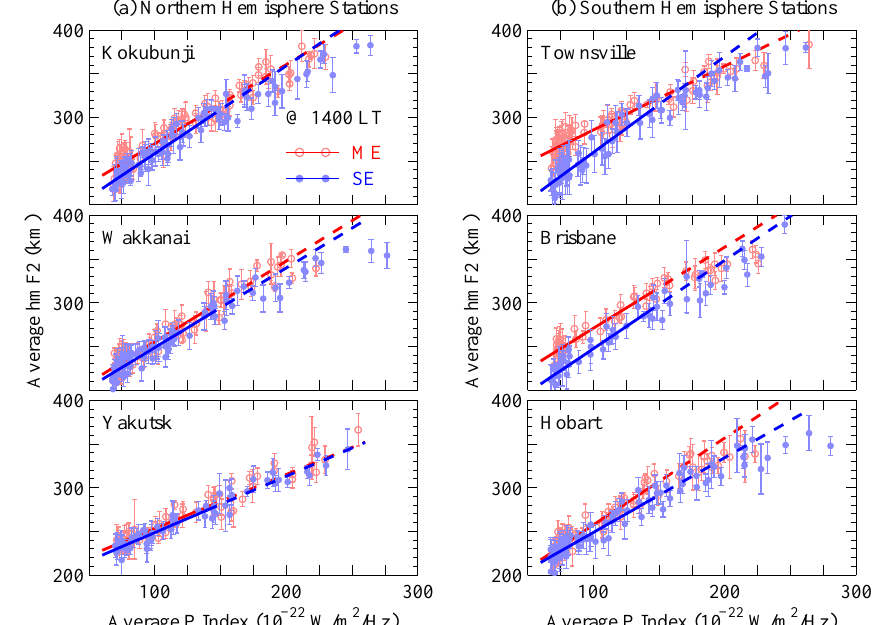
Fig. 8. Same as Fig. 2a but for the variations of hm F2 with the P